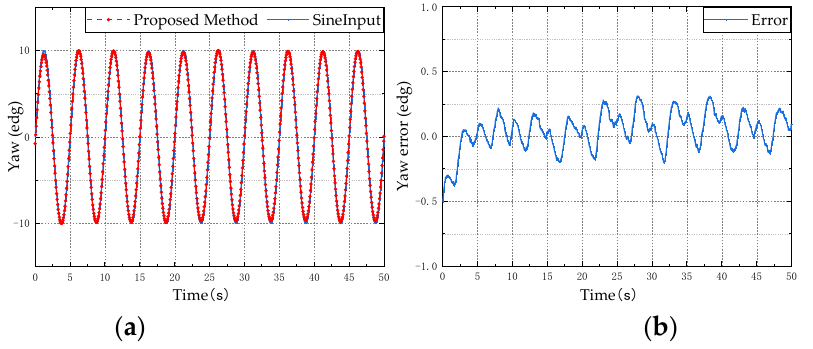
Figure 8. Yaw angle simulation test results: ( a ) is the estimation result of the proposed method; ( b ) is the error between the estimated value and the reference value.